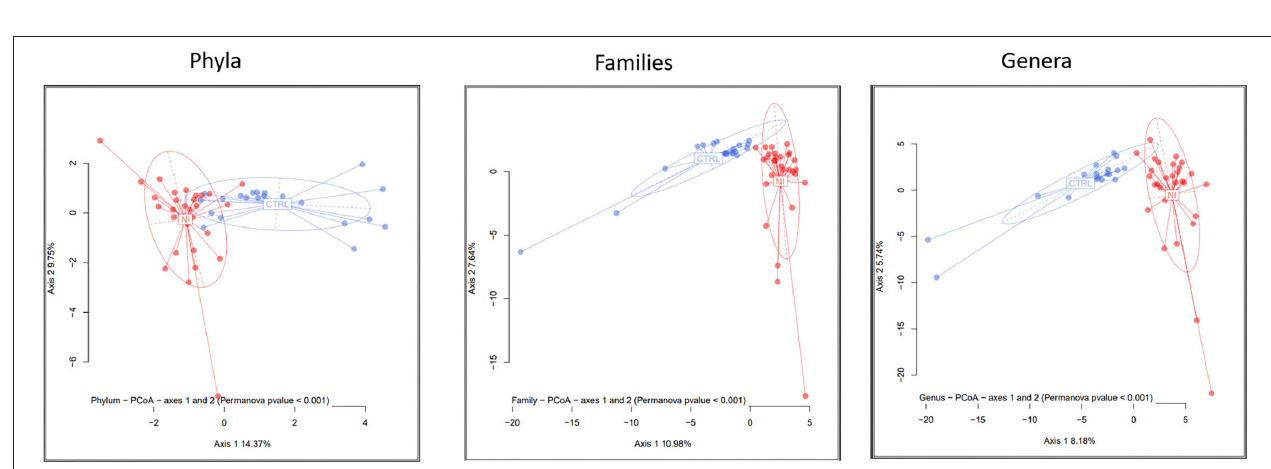
FIGURE 1 | Taxonomic composition of the gut microbiota in patients with neurologically impairment (NI) compared with sex- and age-matched healthy controls (CTRL). Average relative abundance of the most represented phyla, families and genera identified in the two groups. Only taxa whose relative abundance is > 5% in at least one group are included.